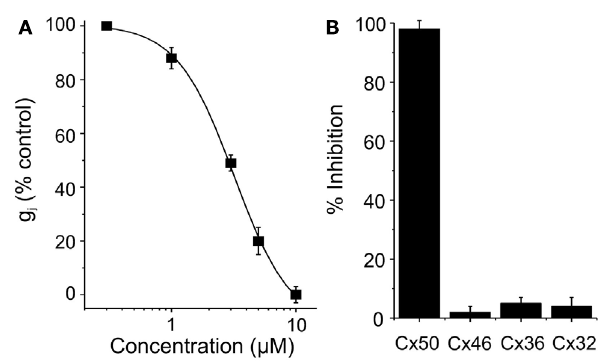
( Figure 7A ). Non-linear least-squares fit of the individual data